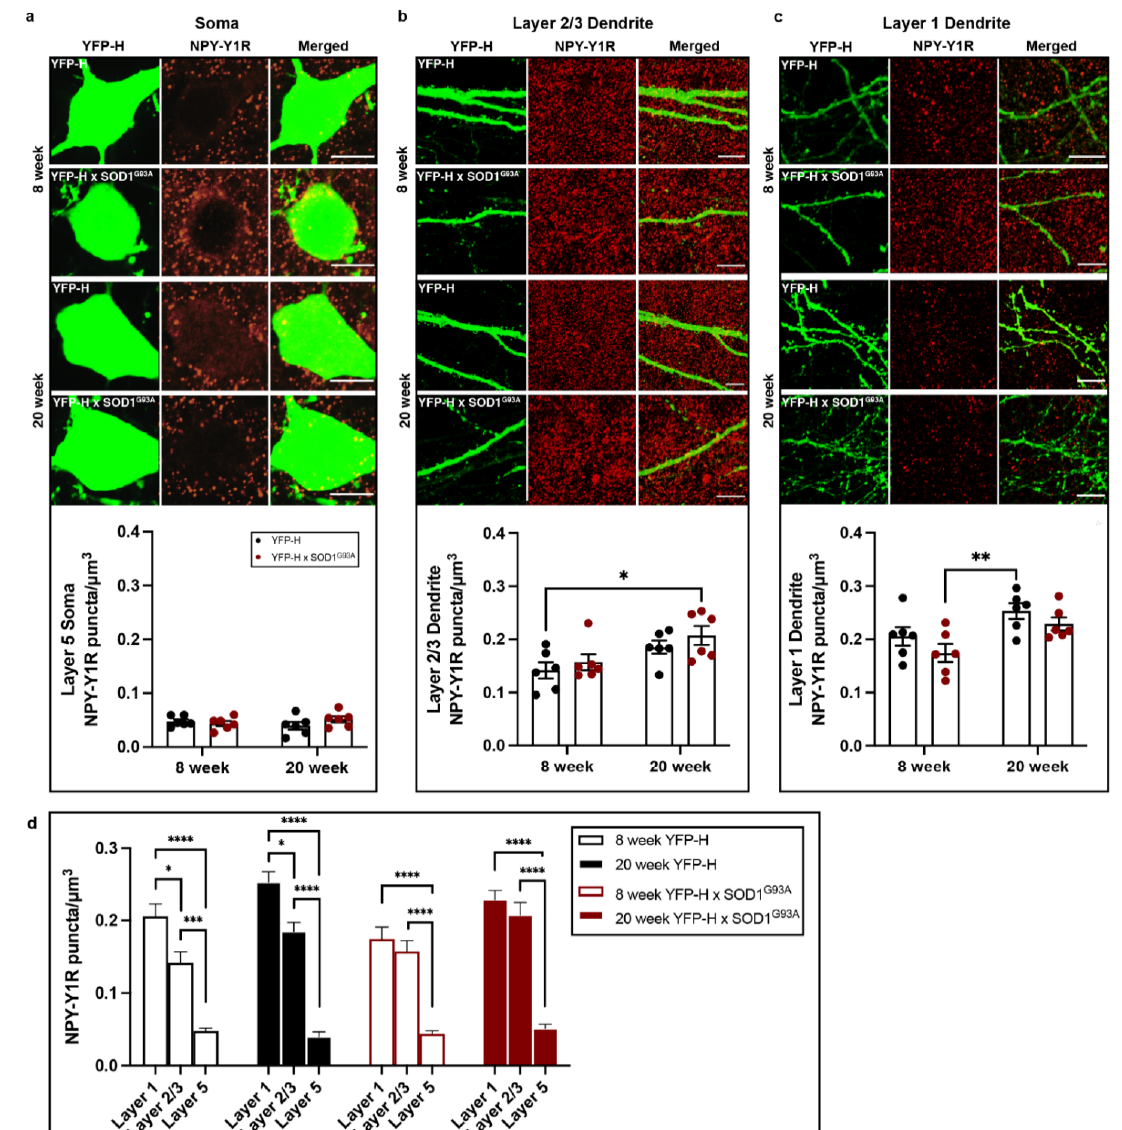
Figure 5. Immunohistochemical investigation of NPY-Y1 receptor density on layer 5 upper motor neurons throughout disease progression in YFP-H::SOD1 G93A ( n = 6 per age group) and YFP-H mice ( n = 6 per age group). ( a – c ) Immunohisto- chemical comparisons of NPY-Y1 receptors (red) localised to the cell soma ( a ) and distal apical dendrites in layers 2/3 ( b ) and 1 ( c ) of YFP-H- (green) positive upper motor neurons between YFP-H and YFP-H::SOD1 G93A mice at 8 and 20 weeks of age. ( d ) Three-way ANOVA comparisons of NPY-Y1 receptor density between cortical layers of YFP-H and YFP- H:: SOD1 G93A mice at 8 and 20 weeks of age. Presented values represent the mean density for individual animals across a minimum of two brain slices. Bars represent the mean ± SEM. * p < 0.05, ** p < 0.01, *** p < 0.001, **** p < 0.0001 . Scale bar = 10 µm.